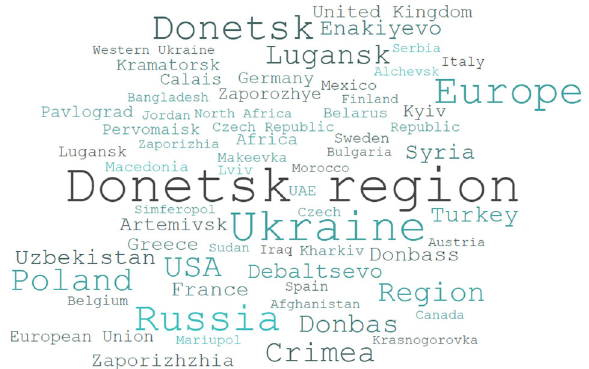
Fig. 2 Semantic core for politonyms in the Ukrainian top media